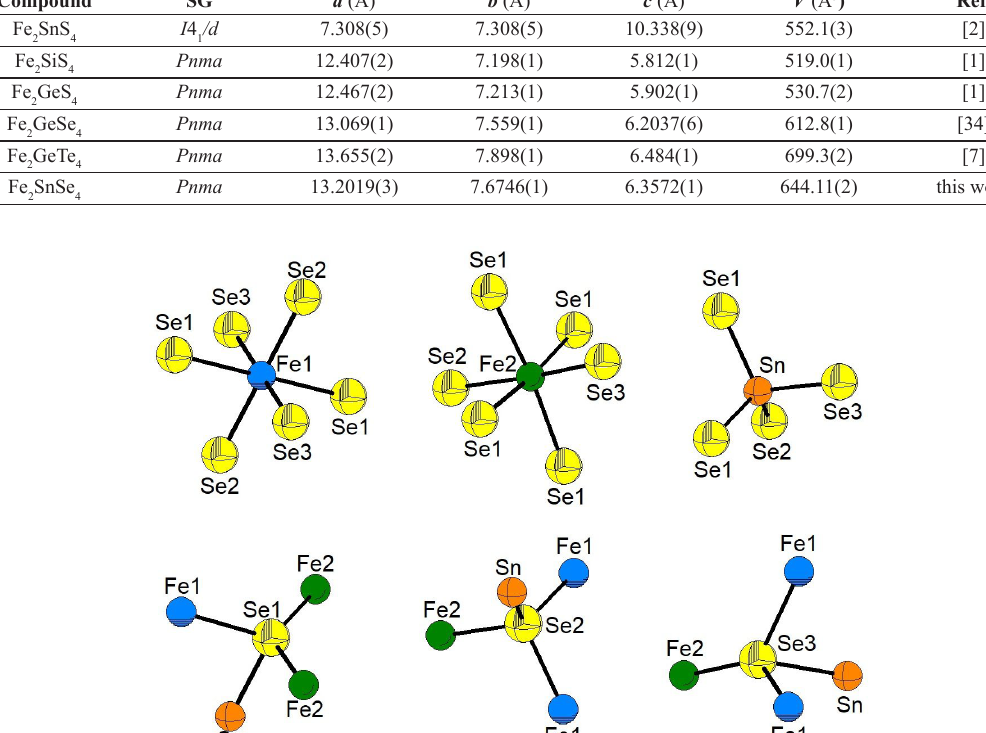
tetrahedra, and 4